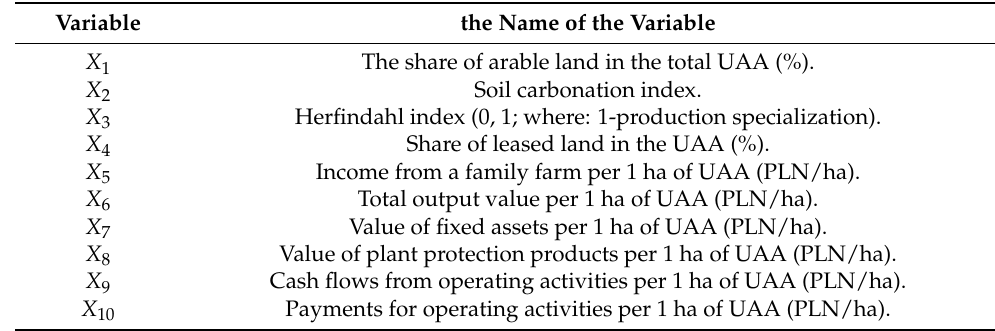
Table 4. The final set of diagnostic variables accepted for the study.